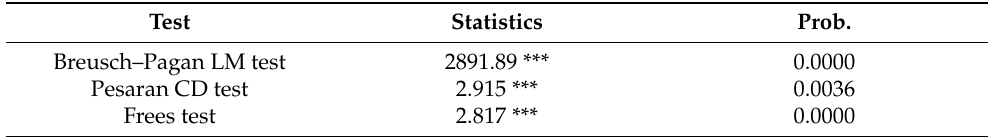
Table 2. Cross-sectional dependency checks. Test Statistics